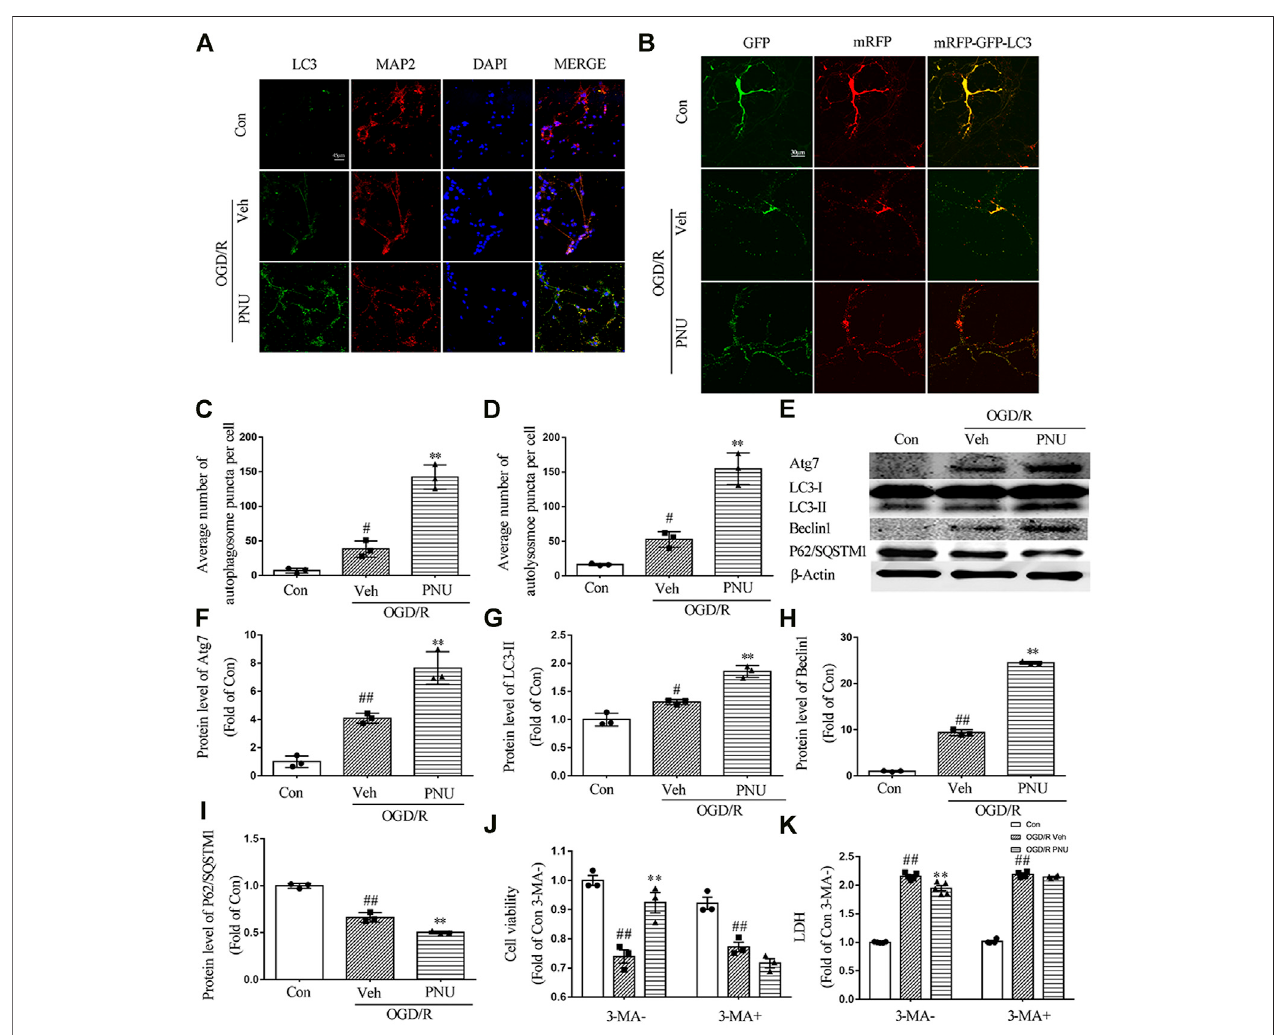
FIGURE4| α 7nAChRactivationenhances autophagy inneuronsuponOGD/R.PrimarycorticalneuronsweretreatedwithvehicleorPNU282987(100 μ M) for2 h before OGD/R. The level of autophagy was detected at 24 h after OGD/R. (A) Representative images of immuno fl uorescence staining of LC3, MAP2, and DAPI. Scale bar, 45 μ m. (B) Representative images of autophagic fl ux. Lentivirus-harboring tandem monomeric mRFP-GFP-LC3 were transfected into neurons. Yellow puncta representautophagosomes,andredpunctarepresentautolysosomes.PNU282987enhancedautophagic fl uxcomparedtoOGD/Rgroups.Scalebar,30 μ m. (C) Quanti fi cation ofautophagosomepuncta. n (cid:2) 3per group. (D) Quanti fi cation of autolysosome puncta. n (cid:2) 3per group. (E – I) Autophagy-related proteins were detected byWesternblot. n (cid:2) 3pergroup. (J) Pretreatmentwith3-MA(1 mM,anautophagyinhibitor)signi fi cantlyinhibitedtheeffectofPNU282987oncellviability. n (cid:2) 3foreach group. (K) Pretreatmentwith3-MA(1 mM,anautophagyinhibitor)signi fi cantlyinhibitedtheeffectofPNU282987onLDHrelease. n (cid:2) 5foreachgroup. # p < 0.05vs.con; ## p < 0.01 vs. con; and ** p < 0.01 vs. OGD/R veh.